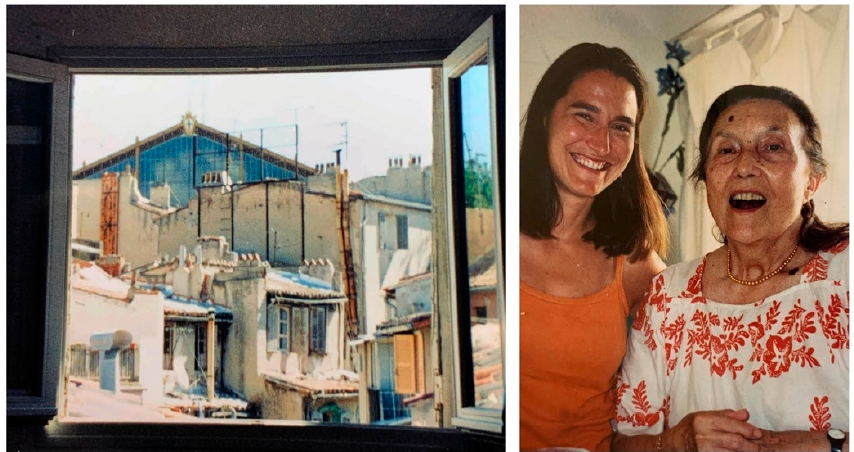
Figure 4. ( Left ) View from an apartment in the Quartier Belsunce. ( Right ) The author, Helen A. Regis, with her aunt Françoise Margaritis in Marseille. Photographs courtesy of the Regis family.